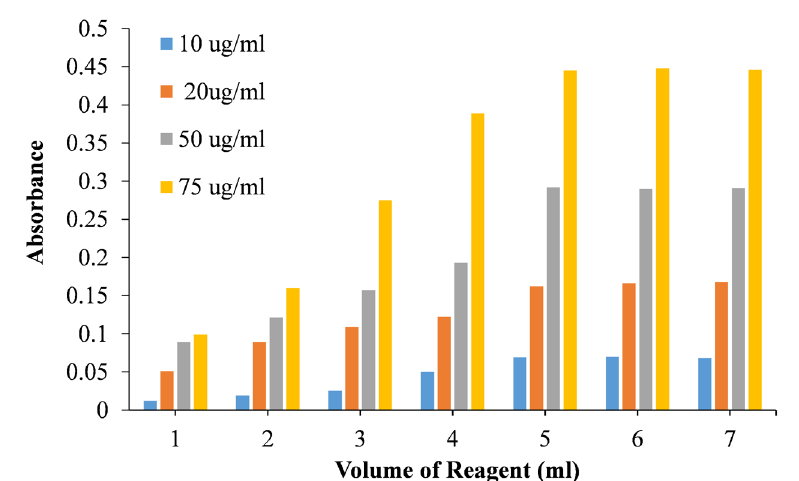
FIGURE 6 - Relationship between different volumes of acetone ninhydrin solution (0.5%w/v) and absorbance of dilutions of